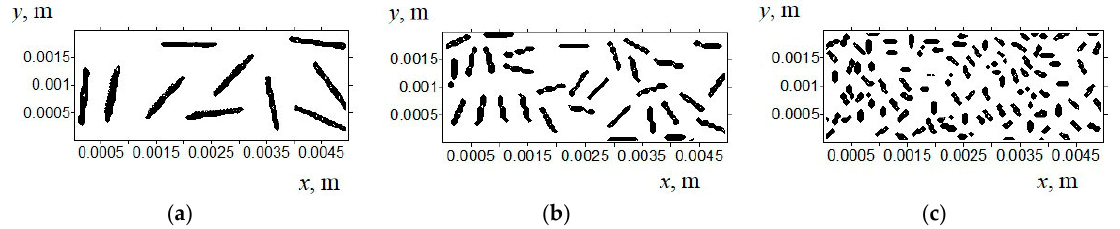
Figure 3. Computational domain for UHMWPE filled with carbon fibers with a length of: ( a ) 1000 µm; ( b ) 500 µm; ( c ) 200 µm. ( b ) 500 µ m; ( c ) 200 µ m.